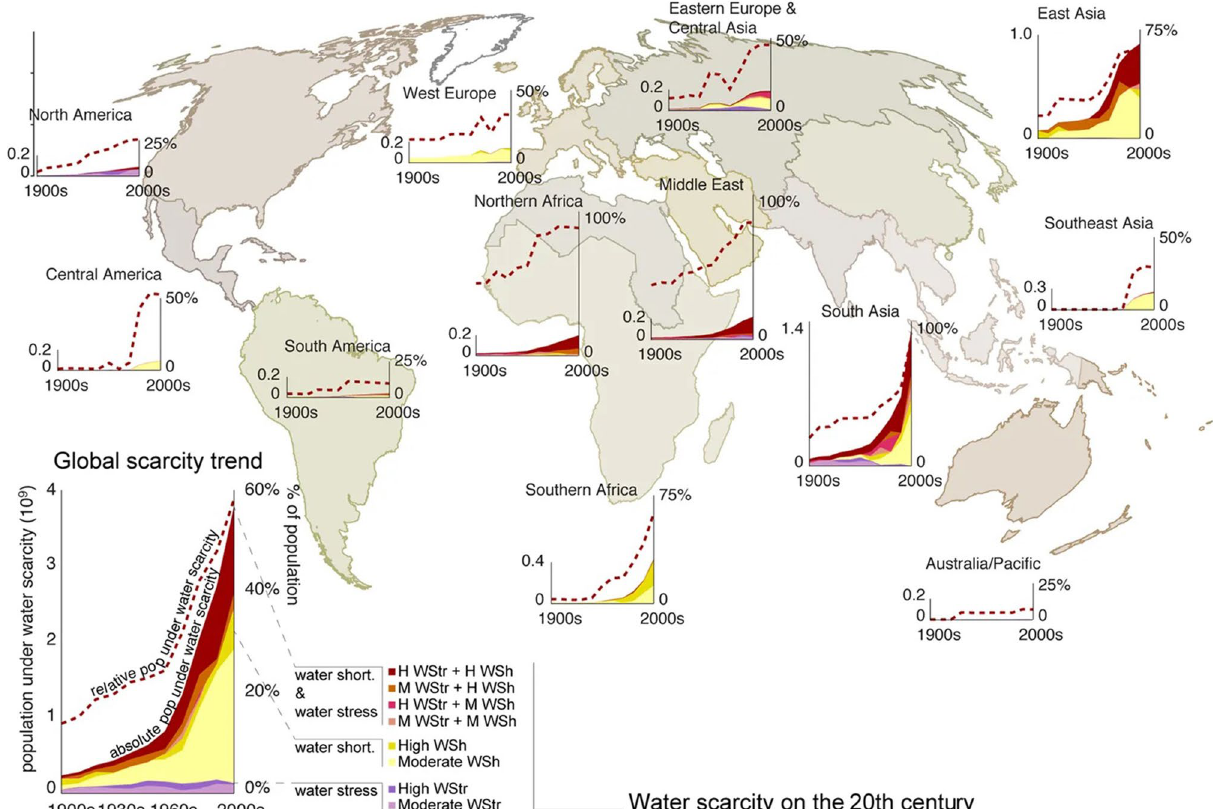
Fig. 1 Water scarcity trends for each area of the globe in the twentieth century (Kummu et al.